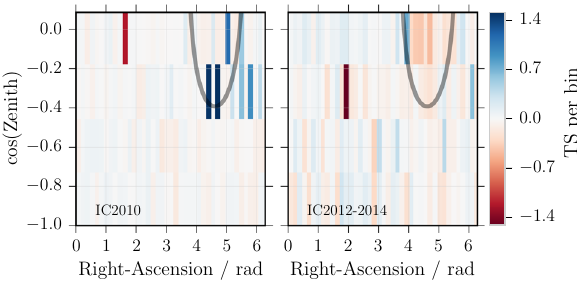
Fig. 5 Track analysis: TS per bin to illustrate the time-dependency of the fit result: blue bins show agreement with the signal hypothesis, red bins favour a purely diffuse astrophysical flux. The gray line indicates the direction where most of the dark matter signal is expected (line-of- sight integral at half of the central value)